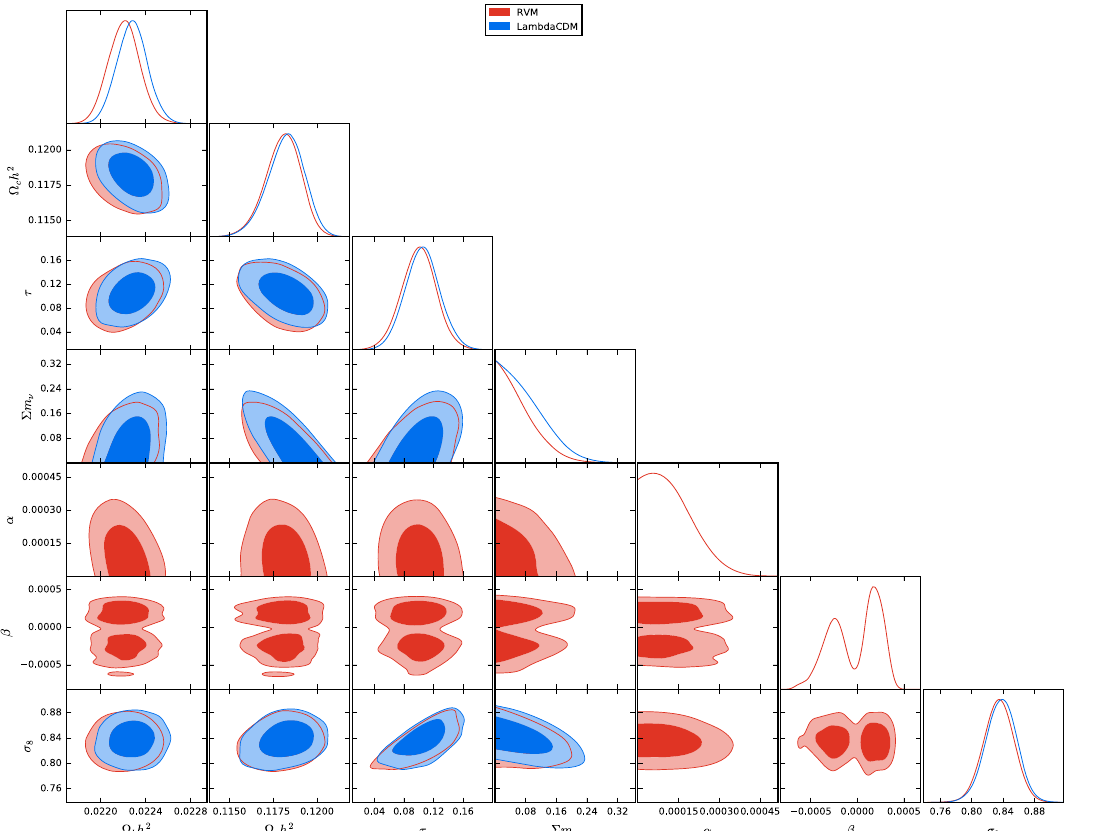
(cid:2) m ν , α , β , σ 8 ,wherethecontourlinesrepresent68% and95%